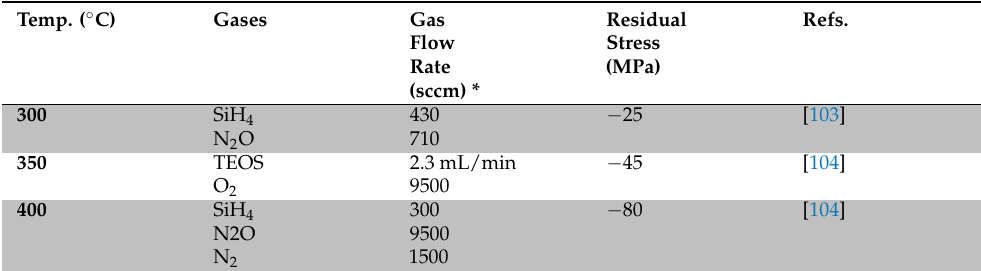
Table 7. Reported process conditions for PECVD silicon dioxide